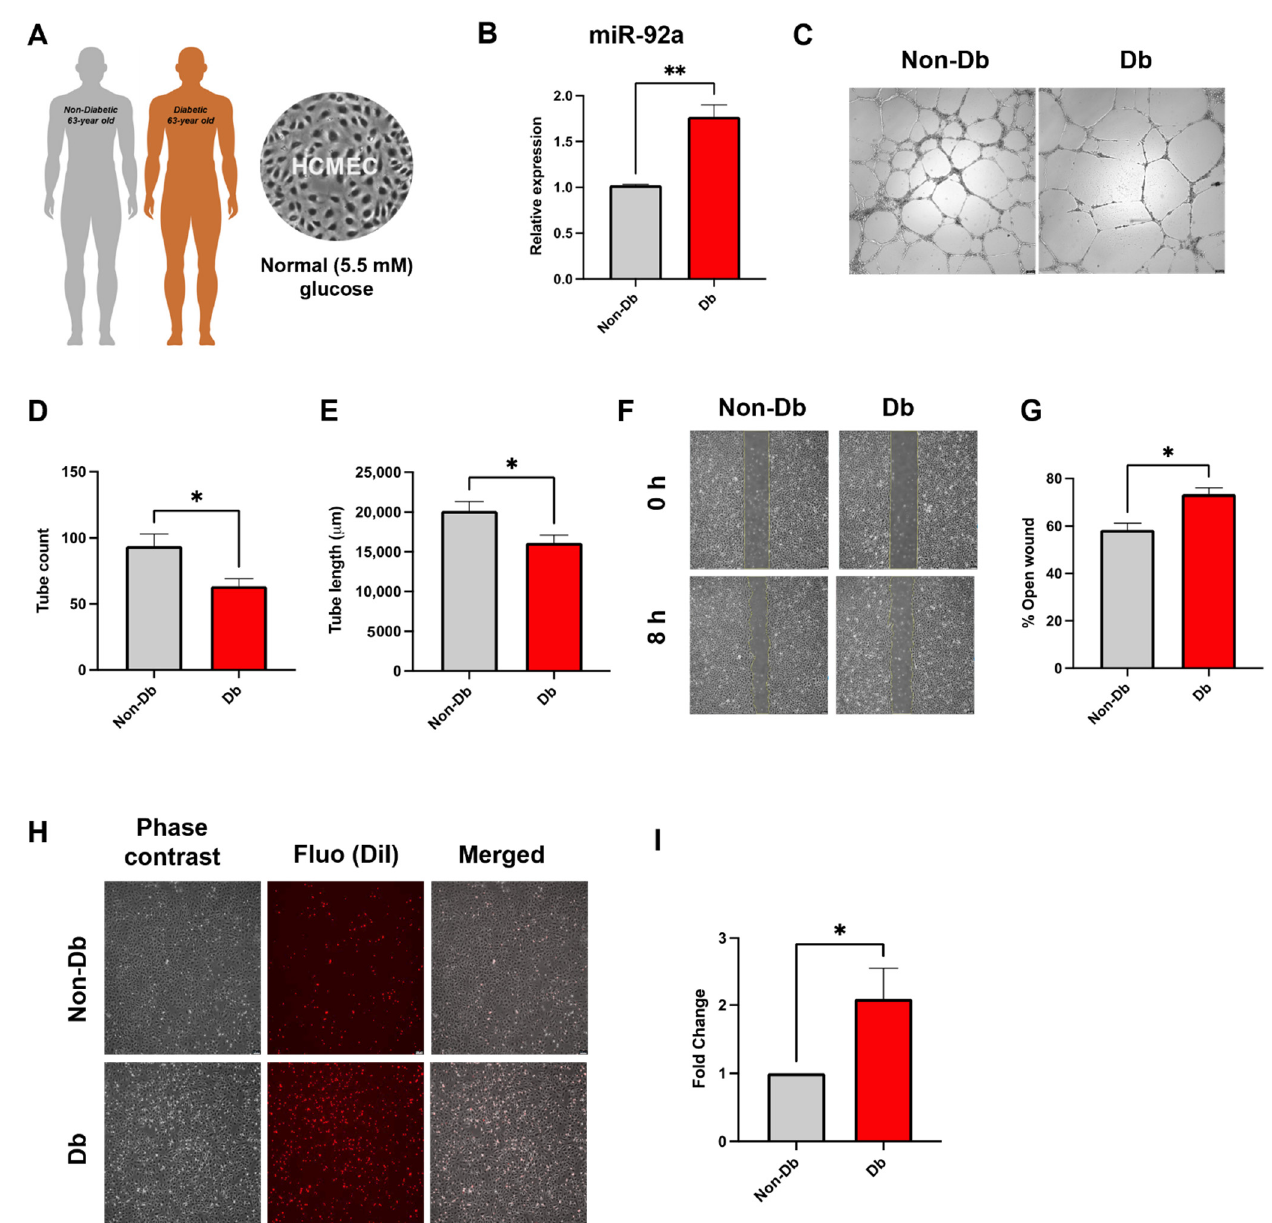
Figure 2. Characterization of type-II diabetic HCMEC. ( A ) Primary HCMEC from 63-year-old caucasian type-II diabetic (Db) patient or age-matched non-diabetic (Non-Db) cultured in normal (5.5 mM) glucose. ( B ) qPCR of miR-92a. ( C – E ) Tube formation of HCMEC on Matrigel. Bright field images and analysis of total tube length and tube count. ( F , G ) Phase contrast images and analysis of relative wound area at 8 h. ( H , I ) Phase contrast, fluorescence images and merge as well as analysis of adherent THP-1 (DiI-labeled) count (fold change) on HCMEC monolayer. Statistical analyses by Student’s t -test ( n = 4). Scale bars = 100 μ M. * p < 0.05; ** p < 0.01.